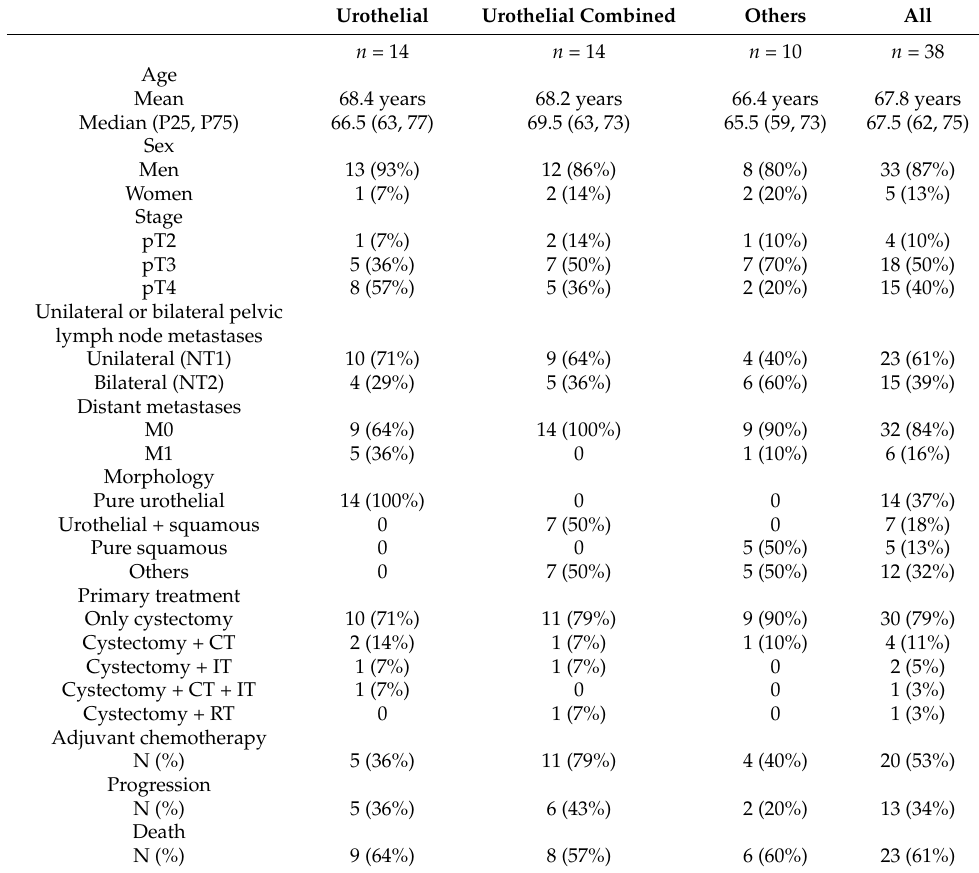
Table 1. Clinical findings in patients with muscle-invasive urinary bladder carcinoma and lymph node metastases ( n =